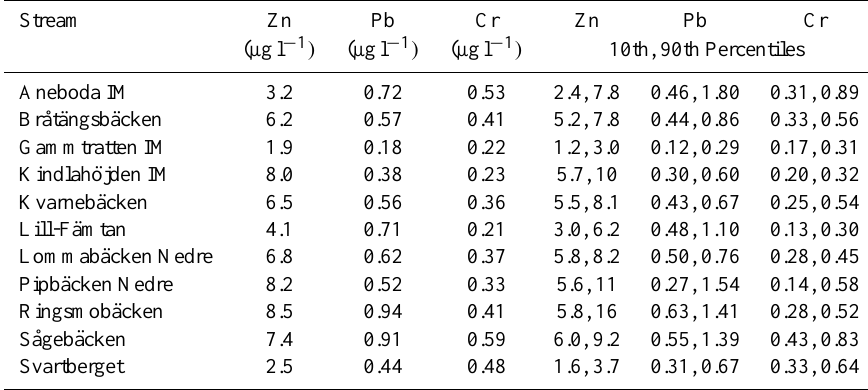
Table 3. Metal concentrations (medians and 10th and 90th percentiles) for each study stream. Stream Zn Pb Cr